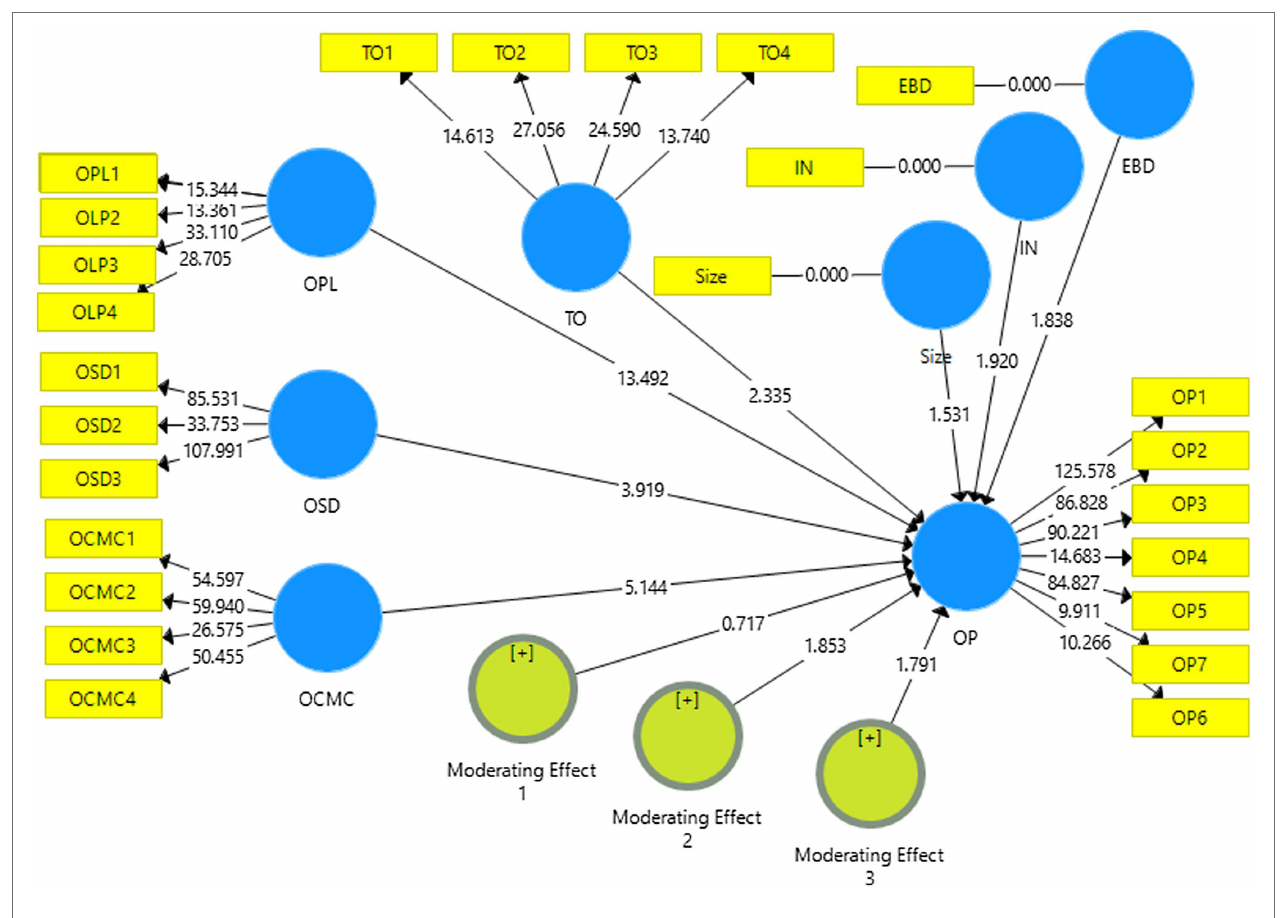
FIGURE 2 | Structural model.